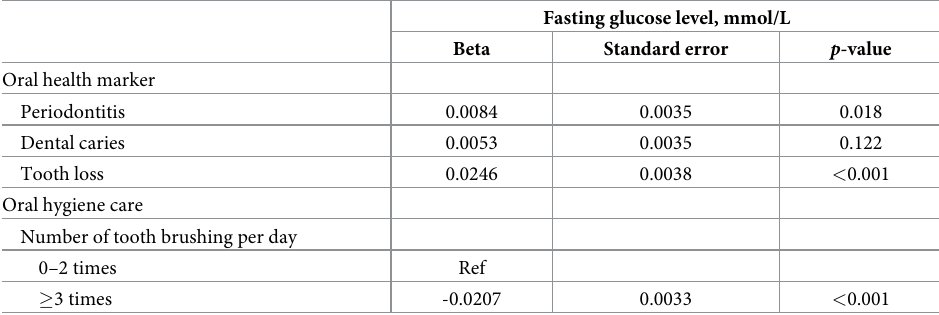
Table 3. Association between oral hygiene markers and fasting glucose levels.